Question: Give a one-sentence summary of this figure.
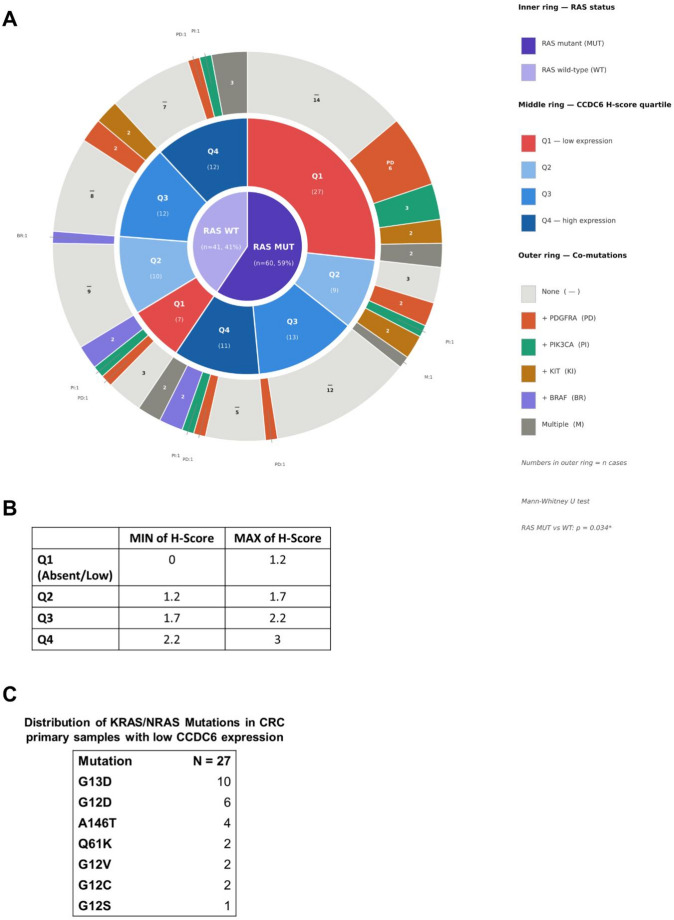
Answer: Distribution of CCDC6 expression according to RAS mutational status in Colorectal Cancer (CRC) primary samples. A Mutational landscape and CCDC6 protein expression in 101 colorectal cancer cases. The three-ring diagram summarises the co-occurrence of RAS (KRAS/NRAS) mutational status, CCDC6 immunohistochemical H-score quartiles, and concomitant gene alterations. Inner ring: RAS mutational status (MUT, n = 60, 59%; WT, n = 41, 41%). Middle ring: distribution of CCDC6 H-score quartiles (Q1-Q4, defined on the entire cohort) within each RAS group. Q1 = absent/lowest expression; Q4 = highest expression. Outer ring: co-mutational profile (PDGFRA, PIK3CA, KIT, BRAF, or multiple alterations) within each quartile subgroup; grey segments indicate cases with no additional mutation among the tested genes. RAS MUT cases displayed significantly lower CCDC6 H-score than RAS WT cases (Mann-Whitney U test, p = 0.034). Abbreviations: MUT, mutant; WT, wild-type; H-score, IHC combinatory score. B The table defines the semi-quantitative scoring criteria used for patient stratification. The H-score range (0–3) was divided into quartiles: Q1 (0–1.2) represents Absent/Low expression, while Q2 (1.2–1.7), Q3 (1.7–2.2), and Q4 (2.2–3.0) represent increasing levels of CCDC6 protein expression. C The table displays the specific distribution of KRAS identified in the CRC samples with low CCDC6 expression